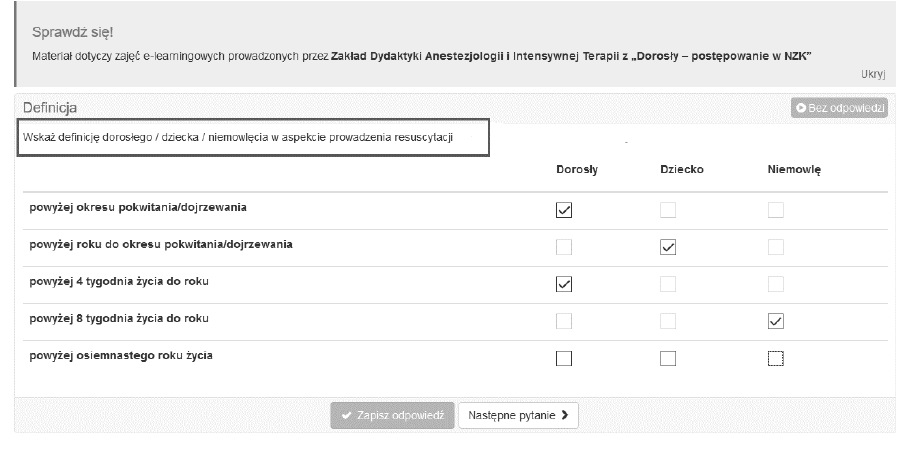
Figure 8. E-learning course in First Aid for year 1 students of Medicine. Example practical tasks in an e-learning course